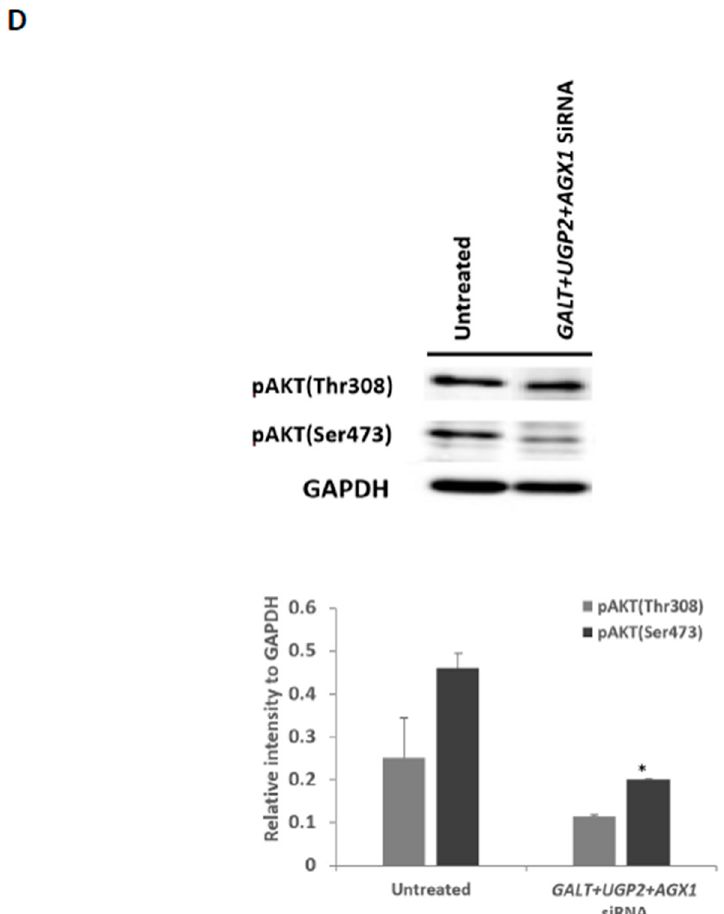
Figure 6. GAL-012 increased sensitivity to tunicamycin in PC3 cells: ( A ) Photomicrographs showing the growth of PC3 cells treated with varying concentrations of GAL-012 in the presence or absence of 0.25 µ g / mL tunicamycin (TM) for 96 h. ( B ) Quantification of cell growth of PC3 treated with varying concentrations of GAL-012 in the presence or absence of 0.25 µ g / mL tunicamycin (TM) for 96 h. ( C ) Western Blot analyses for pAKT (Thr308) and pAKT (Ser473) in PC3 cells treated with GAL-012 in the presence / absence of tunicamycin. ( D ) Western Blot analyses for pAKT (Thr308) and pAKT (Ser473) in PC3 cells treated with siRNAs against GALT , UGP2 and AGX1.UAP1 . * p < 0.05.